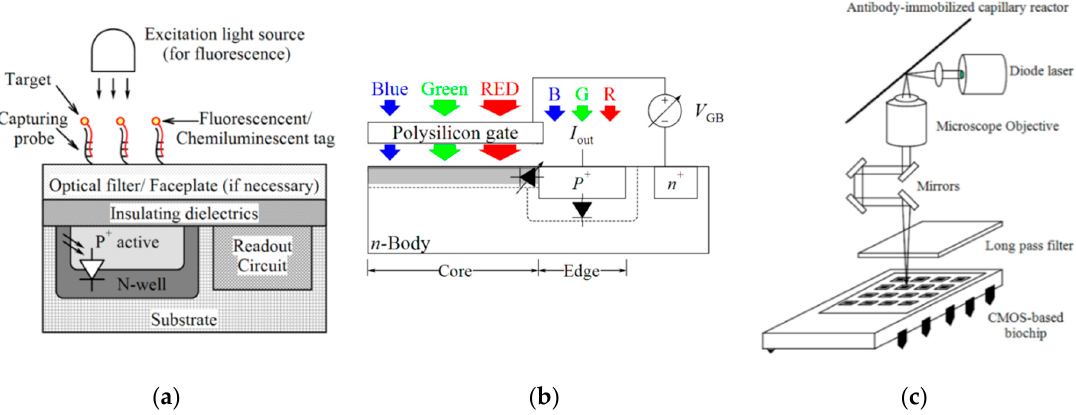
Figure 2. ( a ) Fluorescence/chemiluminescence imaging, ( b ) Cross-sectional view of a filterless CMOS color photogate sensor, ( c ) Schematic diagram of a compact CMOS biochip immunosensor for the detection of a single bacteria.